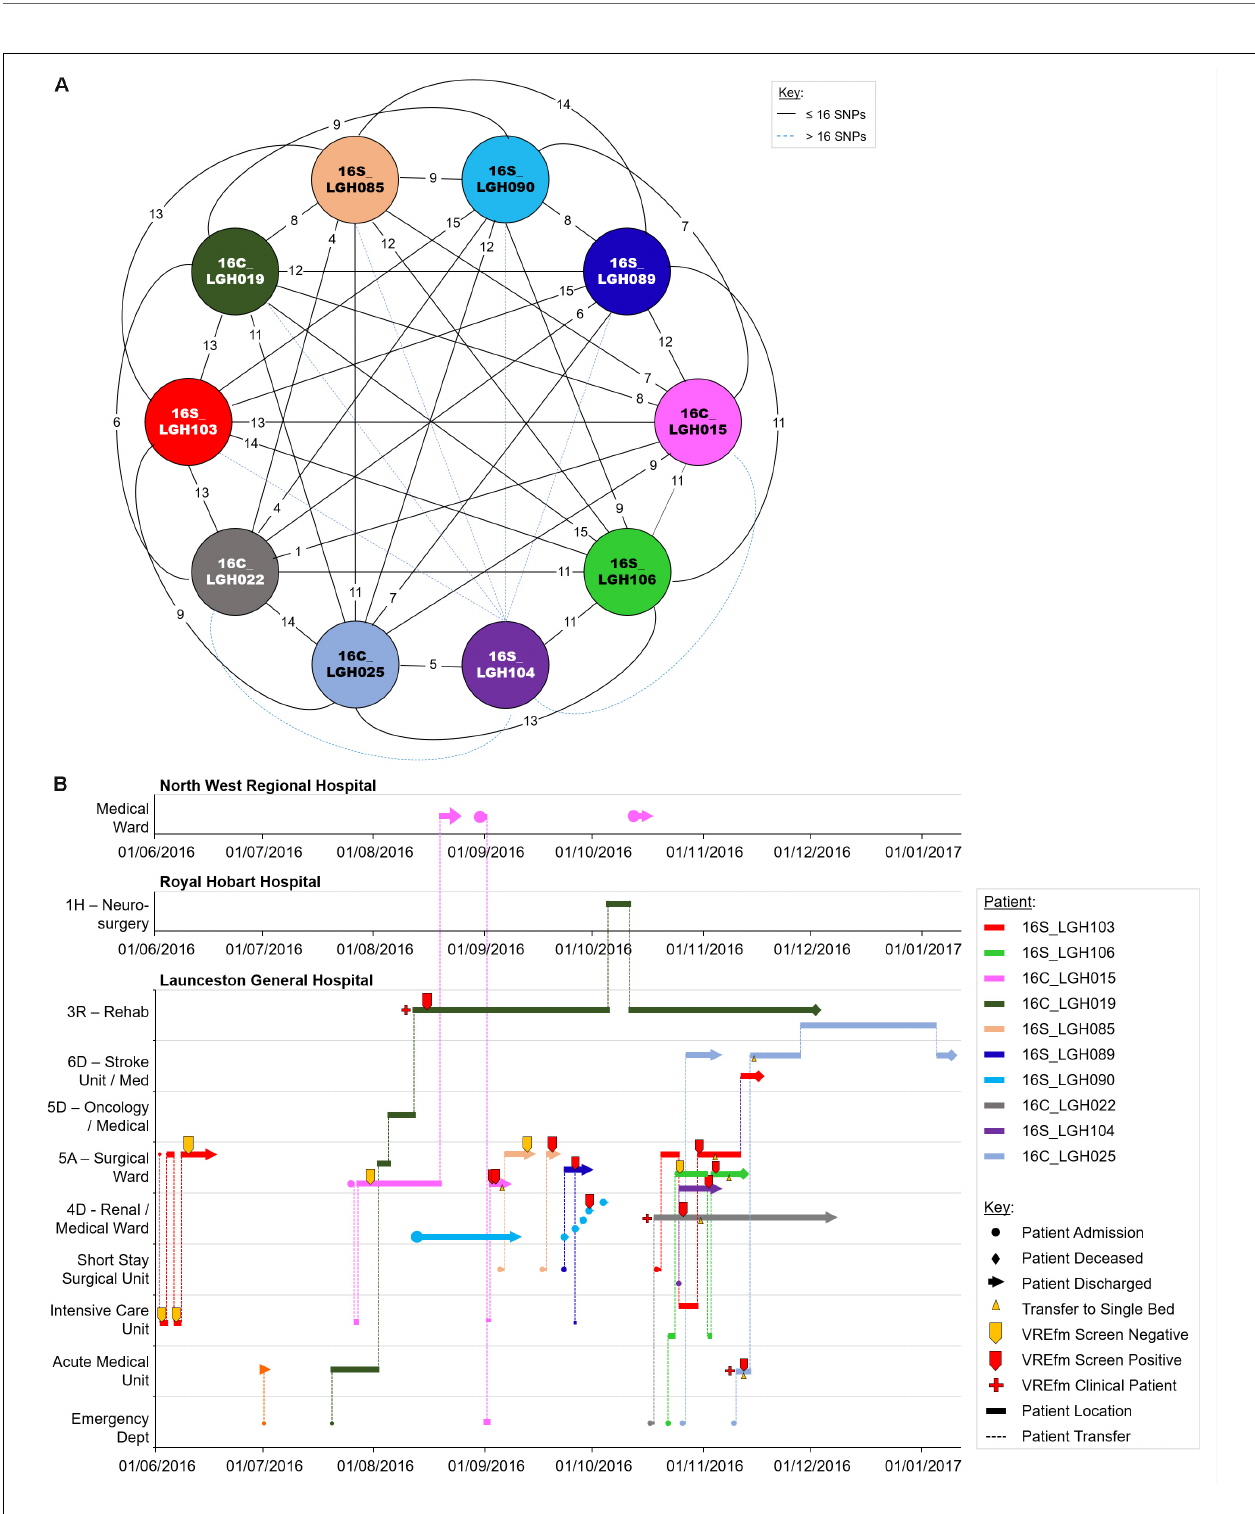
FIGURE 8 | Phylogenetic analysis of vancomycin-resistant Enterococcus faecium (VREfm) isolates from ST1421 Cluster 3B. The previously described recombination-filtered SNP threshold of ≤ 16 SNPs for VREfm has been used as a guide for identifying clonally related or non-unique isolates. (A) Overview of recombination-filtered SNPs between isolates. The numbers of different SNPs between the isolates are shown on the solid black connecting lines. SNP differences above the threshold of 16 SNPs are shown as blue dotted lines. (B) Spatio-temporal location of patients in Cluster 3B who tested positive for VREfm. The movement of patients following admission to hospital through to date of discharge are indicated with respect to time ( x -axis) and hospital ward location ( y -axis). Each line color represents an individual patient. As illustrated, a number of patients had multiple admissions to more than one hospital over the time course.